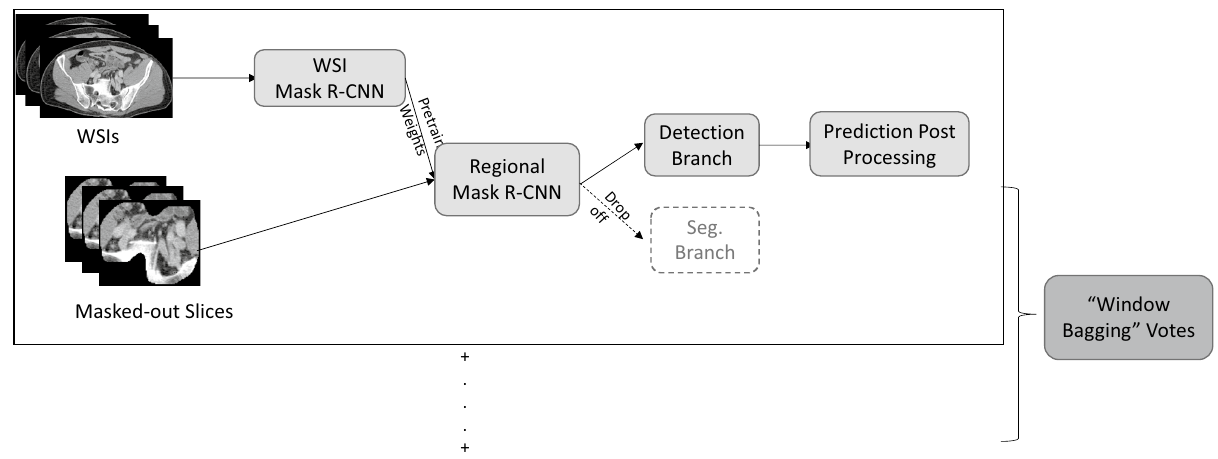
Figure 2. The pipeline for our proposed 2.5D object recognition mechanism of metastatic PCa LNs. Windowing strategies 1 …M represents different HU windowing strategies.